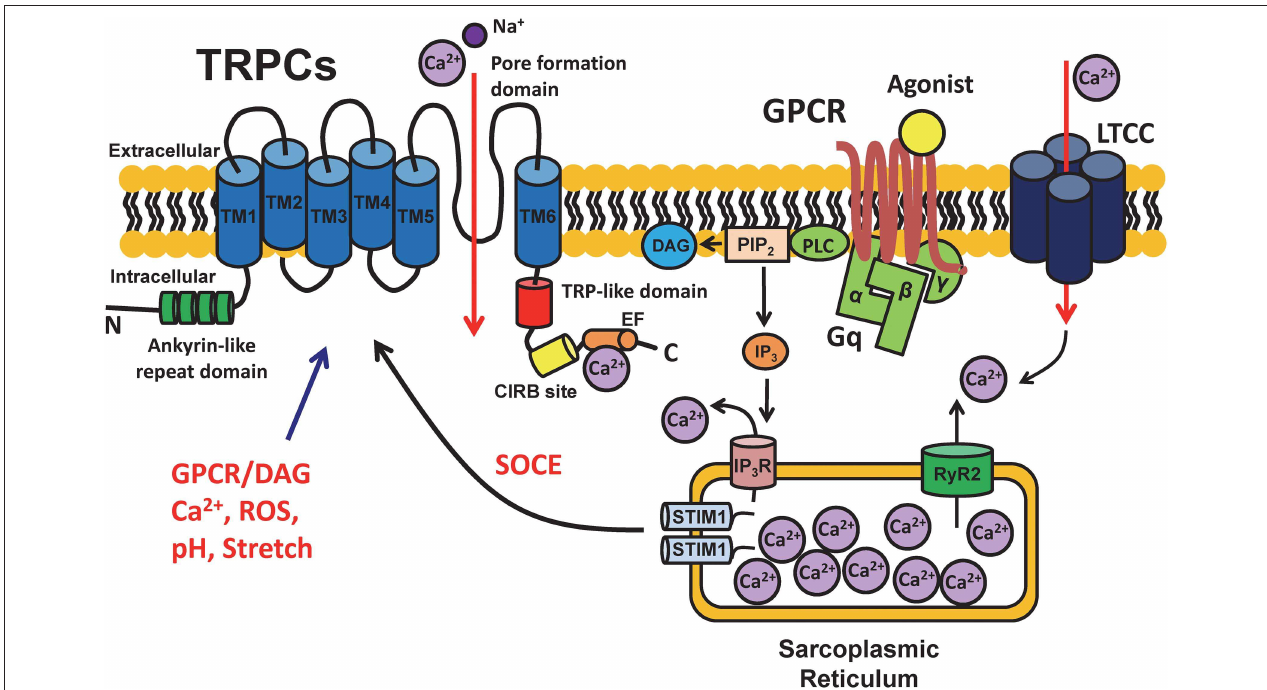
FIGURE 1 | Schematic diagram of the structure of TRPC channels and cell signaling. TRPC channels are cation selective channels and have been demonstrated to have an intracellular amino terminus with ankyrin repeats (green) and carboxyl terminus with a TRP-like domain (red) for desensitization and a calmodulin- and inositol 1,4,5-trisphosphate receptor-binding (CIRB) site (yellow) for IP3 binding, as well as 6 transmembrane domains (blue) and a pore formation domain located between TM5 and TM6. TRPCs play important roles in mediating the intracellular Ca 2 + signaling by incorporating with multiple functional proteins, e.g., G-protein coupled receptors (GPCRs), voltage-gated L-type calcium channels (LTCCs), ryanodine receptors (RyRs), and stromal interaction molecule 1 (STIM1). The schematic is a depiction of the general structure and regulation pathways of all TRPC channels. Structural and functional differences may exist between different TRPC subfamilies based on tissue